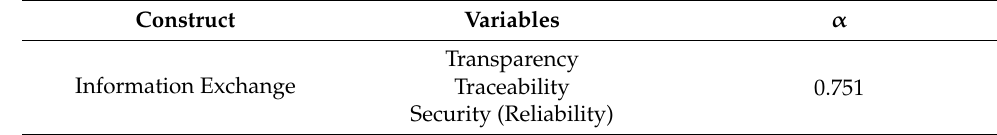
Table 2. Result of Cronbach’s